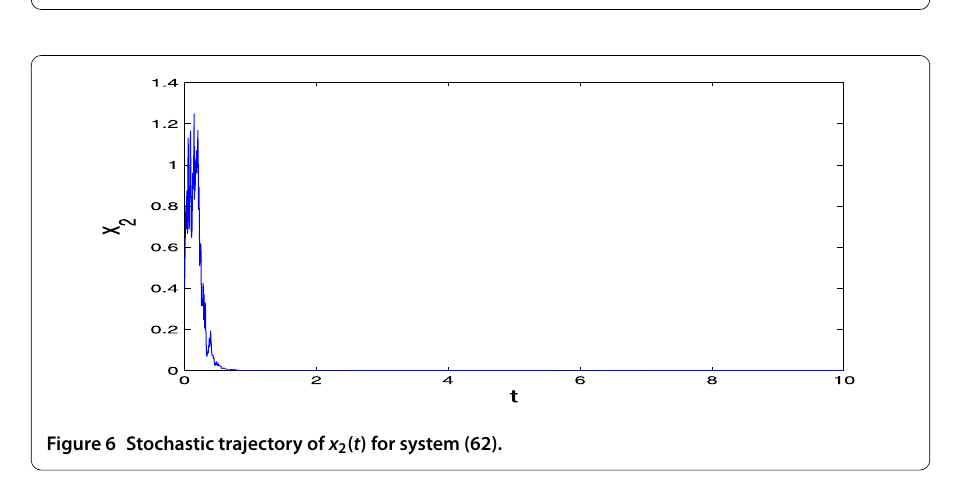
Figure 5 Stochastic trajectory of x 1 ( t ) for system (62).